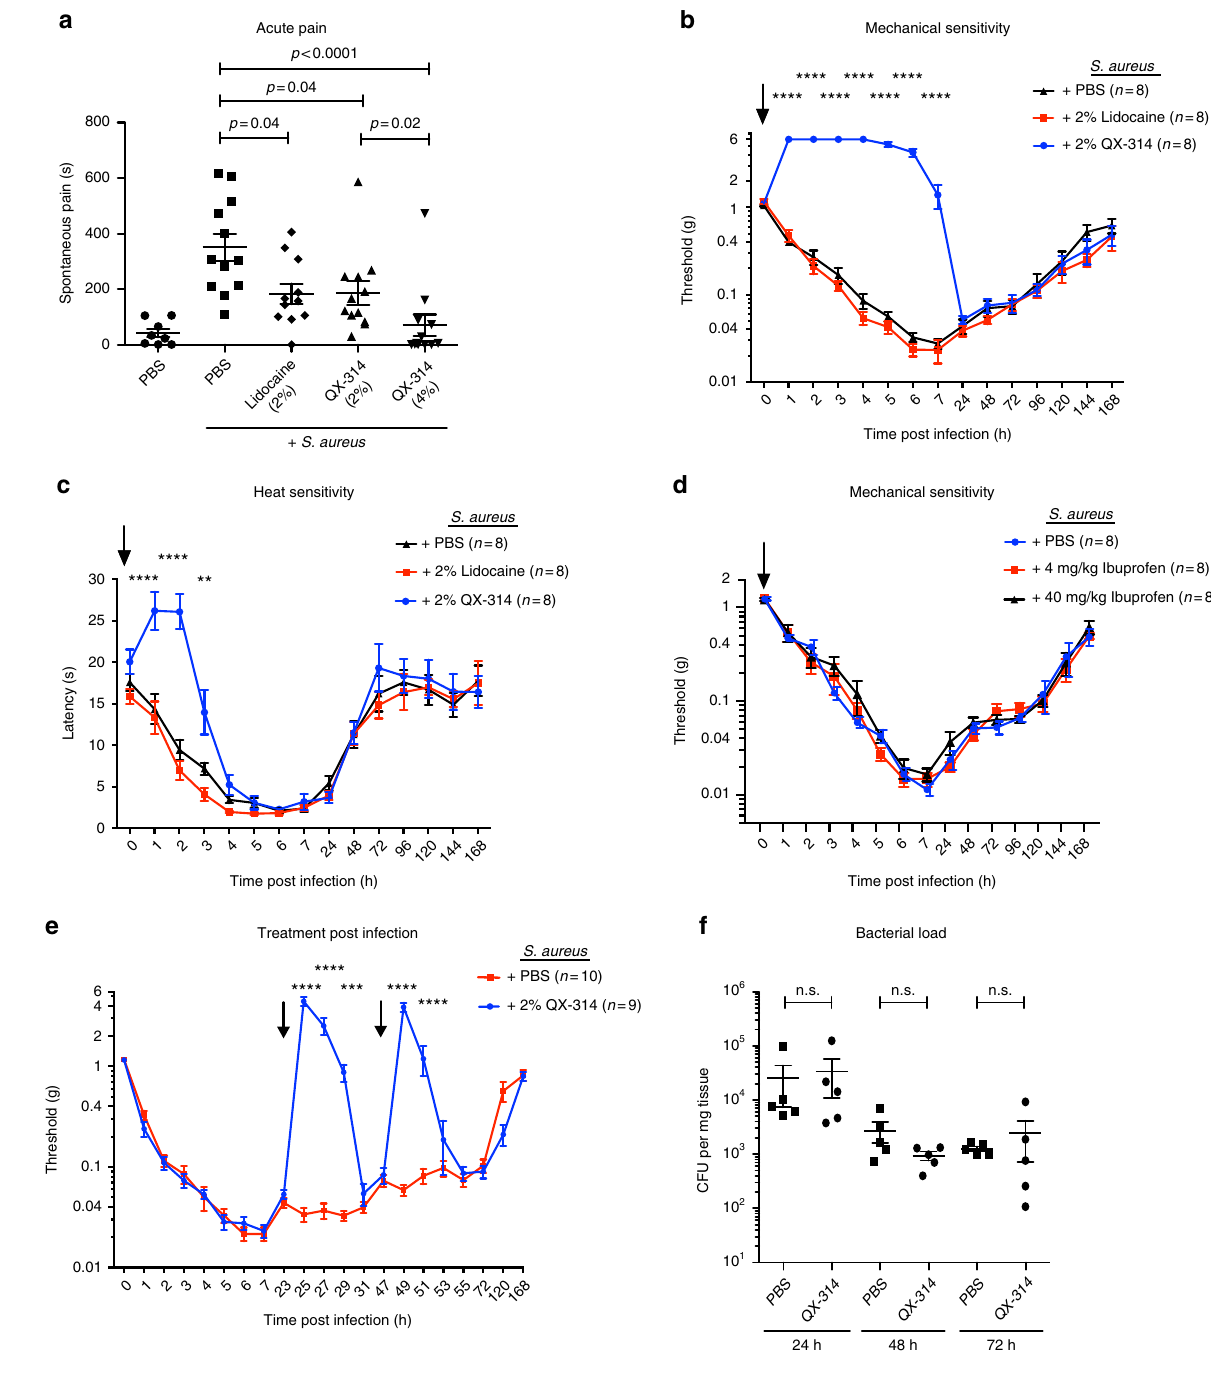
Fig. 7 QX-314 alleviates spontaneous pain, mechanical, and thermal hyperalgesia during S. aureus infection. a Total spontaneous pain over 60 min induced by S. aureus (5 × 10 8 CFU, USA300) injection together with QX-314 (2 or 4%), n = 12 mice per group; lidocaine (2%), n = 11 mice per group; or vehicle (PBS), n = 12 mice per group. Vehicle control (PBS followed with PBS treatment), n = 8 mice per group. p values by one-way ANOVA, Tukey ’ s post-tests. b Mechanical hyperalgesia induced by S. aureus infection (1 × 10 6 CFU) was measured by von Frey hair tests. Mice were co-injected with QX-314 (2%), lidocaine (2%), or PBS at infection (arrows). Statistical comparisons: QX-314 vs. PBS, two-way ANOVA with Tukey ’ s post-tests. n = 8 mice per group. c Heat hyperalgesia induced by S. aureus (1 × 10 6 CFU) was measured by the Hargreaves ’ radiant heat test. Mice were co-injected with QX-314 (2%), lidocaine (2%), or PBS at infection (arrows). Statistical comparison: QX-314 vs. PBS. n = 8 mice per group. p values, two-way ANOVA, Tukey ’ s post-tests. d Mechanical hyperalgesia induced by S. aureus infection (1 × 10 6 CFU) was measured in presence of ibuprofen. Ibuprofen (4 mg/kg or 40 mg/kg) or PBS was co-injected of at the time of S. aureus infection (1 × 10 6 CFU) (arrows), n = 8 mice per group. p values, two-way ANOVA with Tukey ’ s post-tests. e Mice were infected with S. aureus (1 × 10 6 CFU) and injected with QX-314 (2%) or with PBS at two indicated time points post infection (arrows indicate QX-314 or PBS injections). n = 9 – 10 mice per group. p values, two-way ANOVA, Sidak ’ s post-tests. f Bacterial load of S. aureus infection (1 × 10 6 CFU) after treatment (1, 2, or 3 times) with 2% QX-314. n = 5 mice per group. a N = 4 replicates; b , c N = 2 replicates; d – f N = 1 replicate. p values, one-way ANOVA with Tukey ’ s post-tests. **** p < 0.0001, *** p < 0.001, ** p < 0.01, * p < 0.05. Error bars throughout fi gure, mean ±